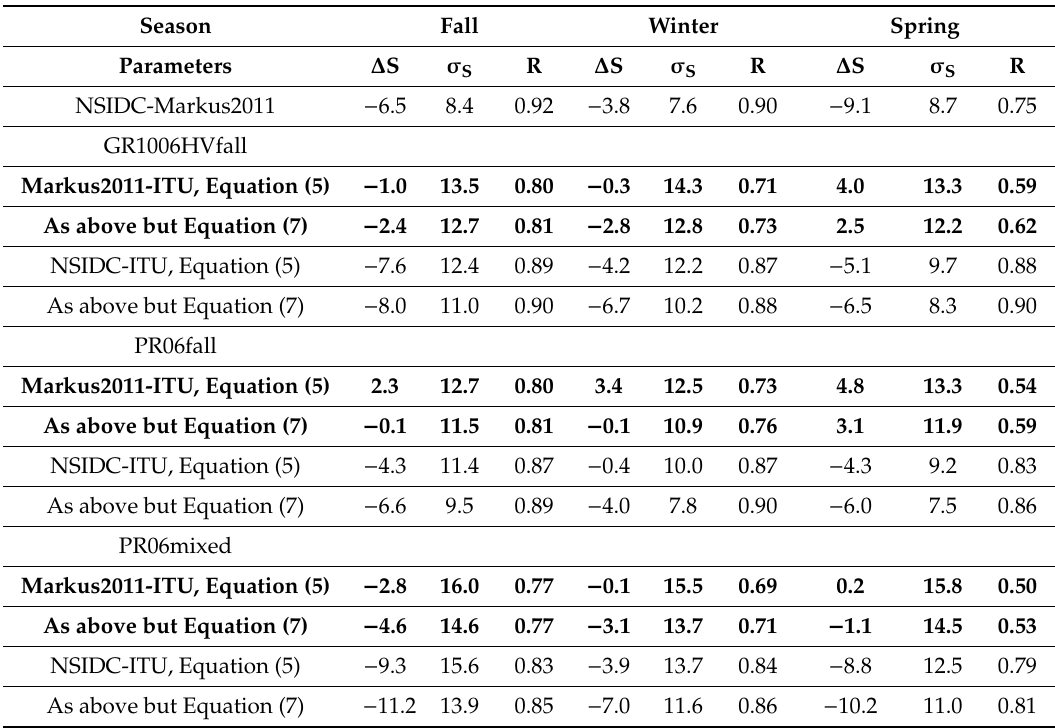
Table 4. The mean snow-depth di ff erence ∆ s and its standard deviation σ s , both in centimeters, and the linear correlation coe ffi cient R computed between NSIDC and Markus2011, and between both these algorithms and the three ITU-algorithm implementations shown in Figure 9. The results are given for Equations (5) and (7) implementations, as noted in the first column. Note that Table 4 includes values for fall, i.e., the months of March to May, not shown in Figure 9. The results of the comparison between Markus2011 and ITU are highlighted in bold font.